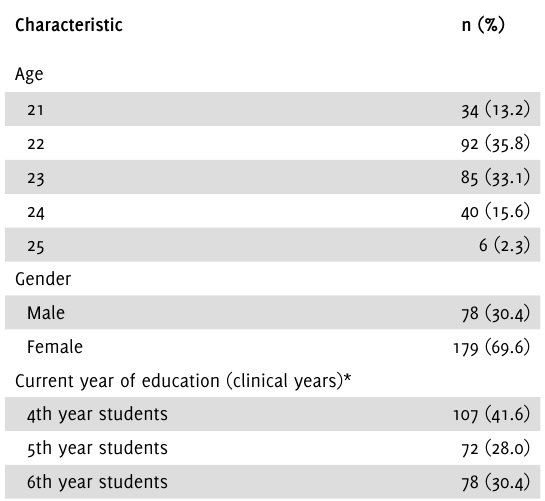
Table 1. Characteristics of Study Participants (N = 257)